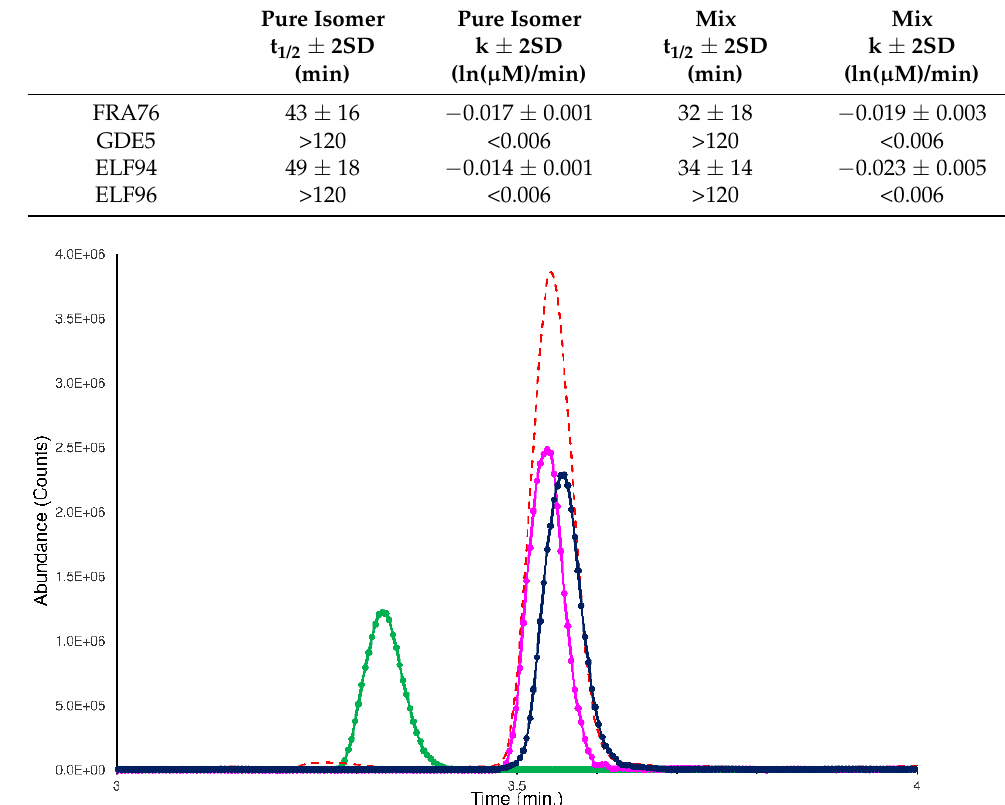
Figure 7. The LEDA reconstructed chromatographic profiles of the human plasma sample spiked with the mixture of the ELF94 (pink line) and ELF96 (blue line) isomers at the incubation time 0 min. The IS (green line) and Ri (red dotted line) signals were also reported.